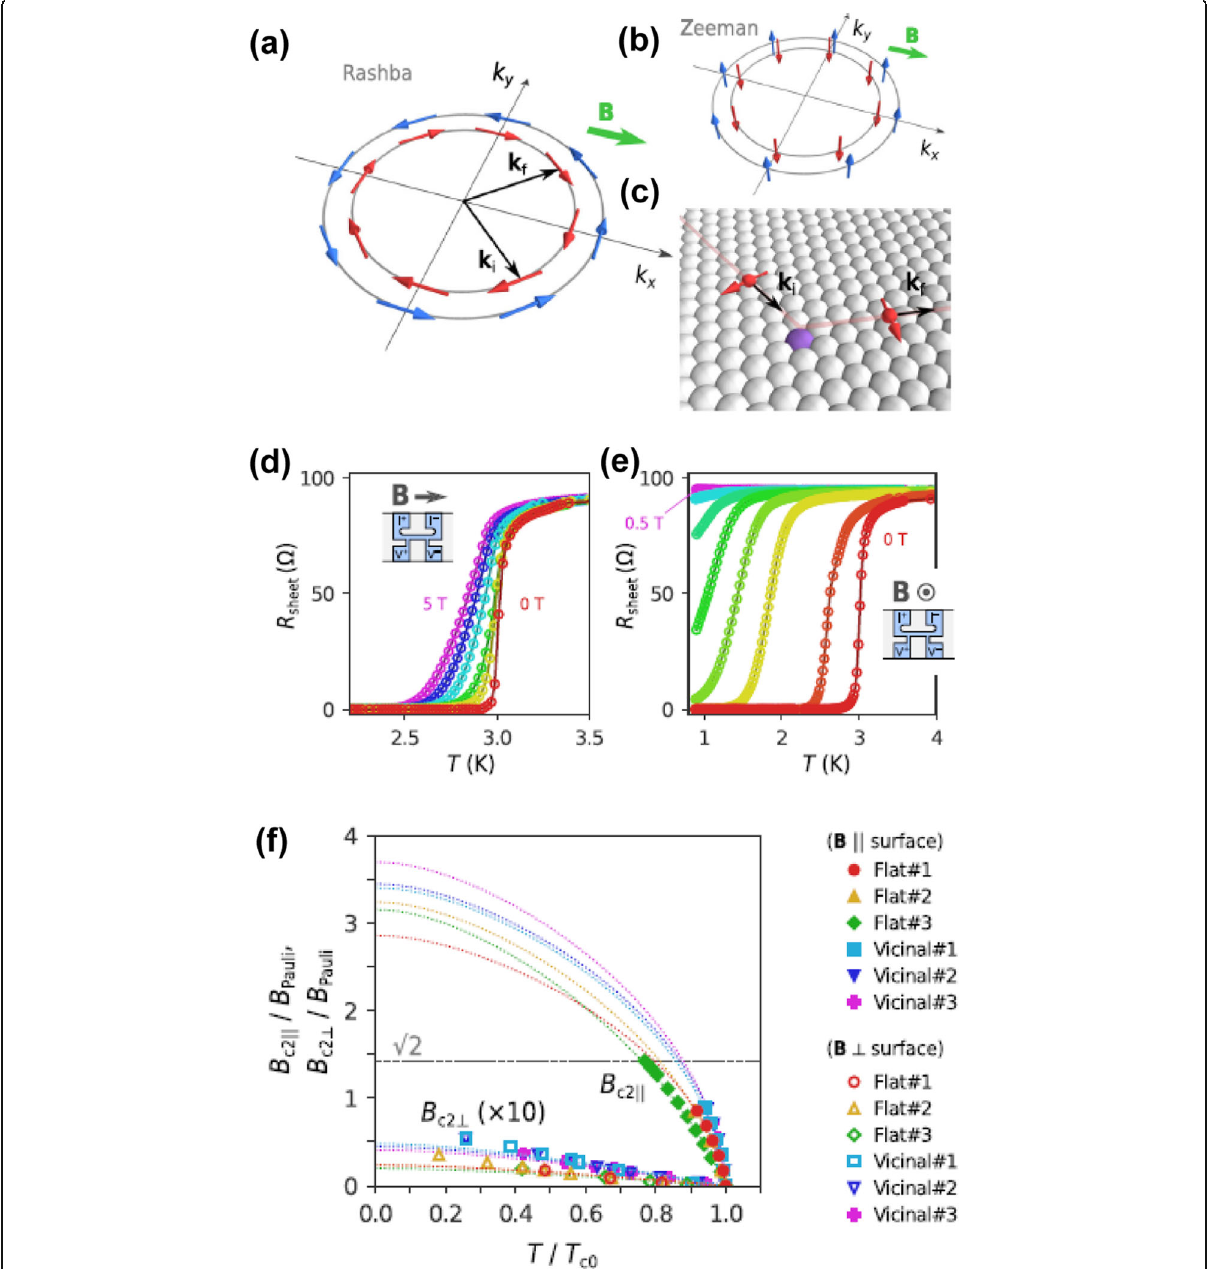
Fig. 10 In-plane critical magnetic field of Si(111)-( √ 7 × √ 3)-In. a Fermi surface with Rashba-type spin-splitting. b Fermi surface with Zeeman-type spin-splitting. c Schematic illustration of dynamic process of spin-momentum locking. d , e Temperature dependences of sheet resistance for in- plane ( d ) and out-of-plane ( e ) magnetic fields. f Temperature dependences of the in-plane and out-of-plane critical magnetic fields normalized with the Paul limit. Reprinted from Macmillan Publishers Ltd: S. Yoshizawa et al., Nat. Commun. 12 , 1462 (2021) [81].